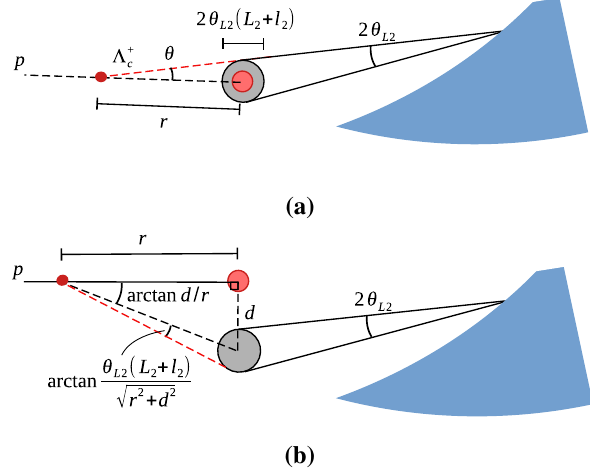
Fig. 5 Ifweimaginethecrystalfacetobeequidistanttothefocalpoint, i.e l 2 = 0, then the Lindhard angle projected from every entry point of the crystal defines a circumference (in grey). The extended trajectory of the (cid:2) + c particles must overlap this circumference (cylinder in 3D) to be trapped in the crystal. For coinciding focal points (a), the trap- ping condition depends simultaneously on the (cid:2) + c aperture angle, θ , and the distance between the production and the focal point of the first crystal lens, r (both projected onto the bending plane). To define the trapping condition for vertically displaced focal points (b), we assumed the impinging proton to be horizontal, as deviations of the proton tra- jectory for positive and negative angles approximately cancel out. This allows to take a right angle and extract the trapping condition with only one additional parameter: the distance d between the two